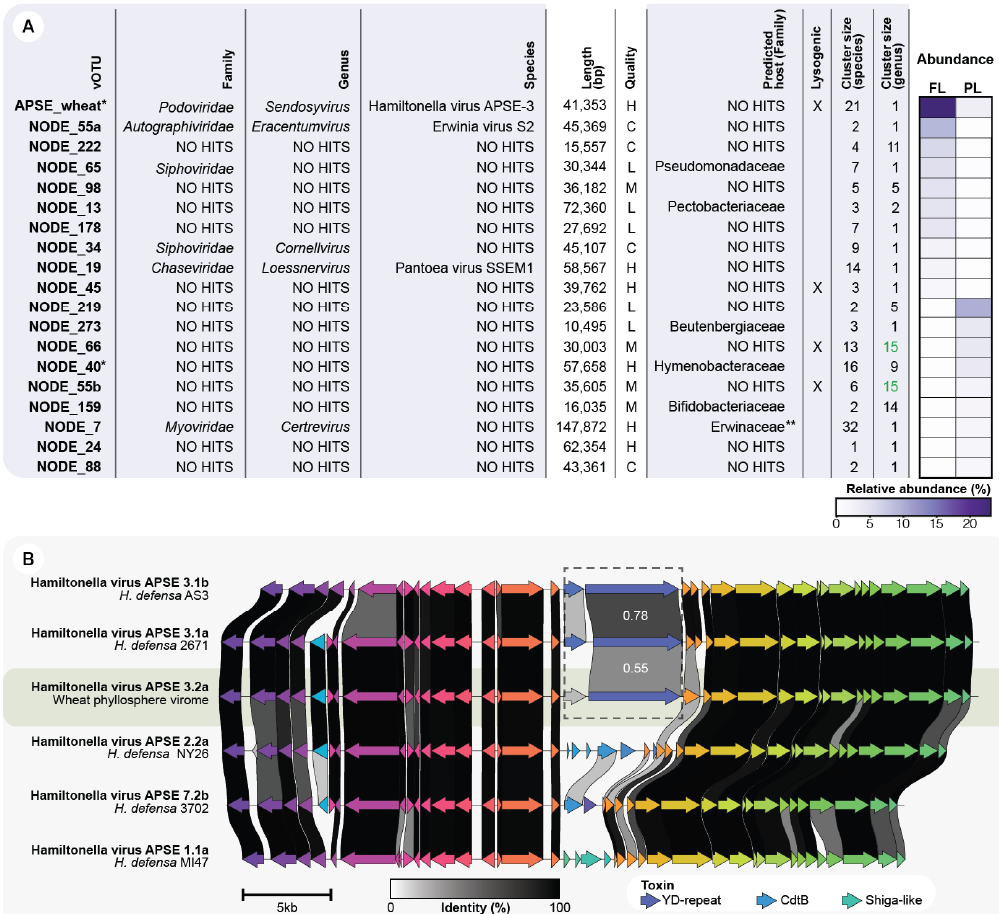
Figure 4. ( A ) Description of the ten top-rank abundant phages of each leaf sample (FL and PL). Taxonomic assignments at genus and family levels were made using vConTACT2 and at species level using nucleotide clustering at >95% identity and >85% sequence coverage. The species cluster size represents the number of viral contigs clustered in a vOTU (species-level). On the other hand, genus cluster size refers to the number of viral species (vOTUs) belonging to the same genus cluster assigned by vConTACT2: (C) Complete, (H) High quality, (M) Medium quality, (L) Low-quality, and (U) Unclassified. * Contigs assembled from a subsampled dataset, ** Viral contig matching a CRISPR spacer predicted from the microbial fraction assembly. Green font indicates the two vOTUs that are part of the same genus cluster. ( B ) Comparative genomics between the wheat phyllosphere APSE phage and the reference genomes of the APSE-1, APSE-2, APSE-3, and APSE-7 subtypes. The amino acid identity between the YD-repeat toxins is indicated in white numbers, and predicted open reading frames are colored by protein groups.